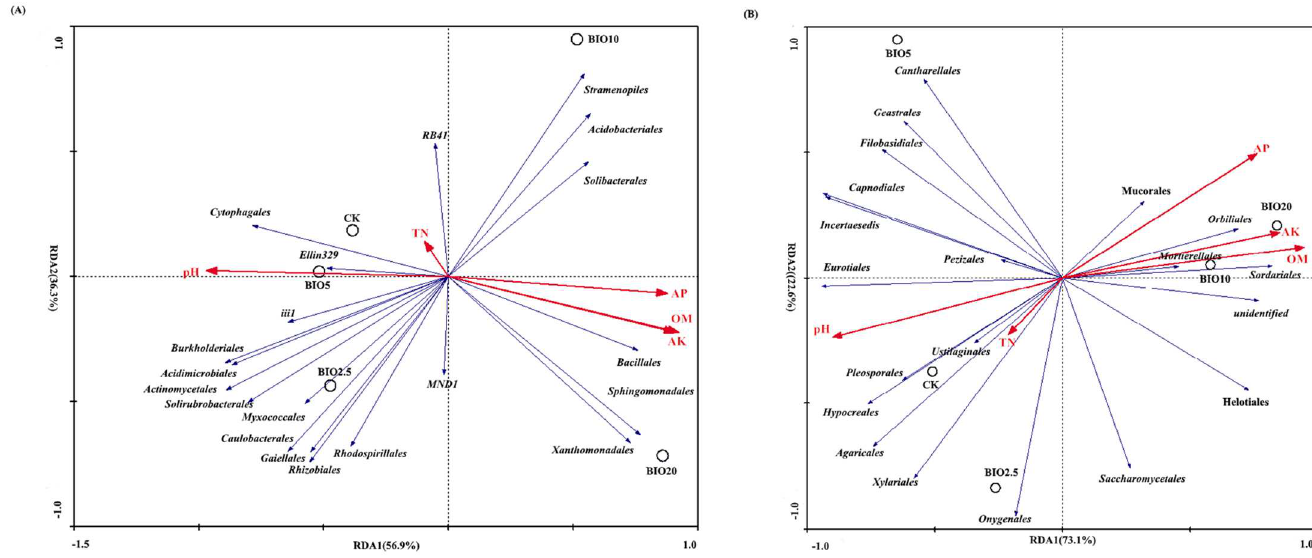
Fig 9. RDA based on the relative abundances of the top 20 bacterial orders and selected soil properties of the soil samples collected from the treatments and CK. Selected soil chemical propertieswere significantly correlatedwith variations in the selectedbacterial (A) and fungal(B) genera accordingto the Monte Carlo test ( p < 0.05). TN: total nitrogen, OM: organic matter, AP: availablephosphorus, AK: